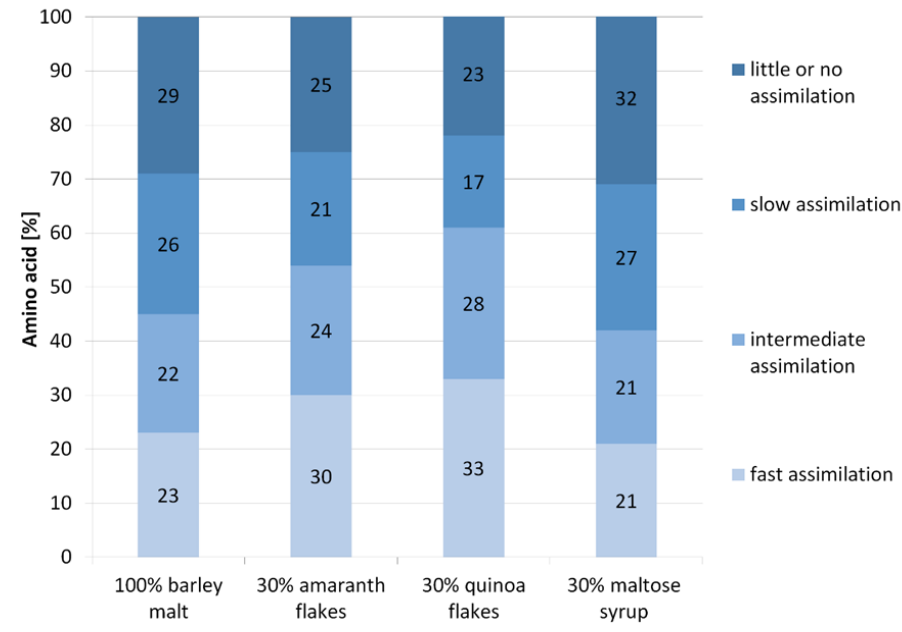
Figure 2. The percentage composition of the groups of amino acids in tested worts. Group A (fast assimilation), Group B (intermediate assimilation), Group C (slow assimilation), Group D (little or no assimilation).